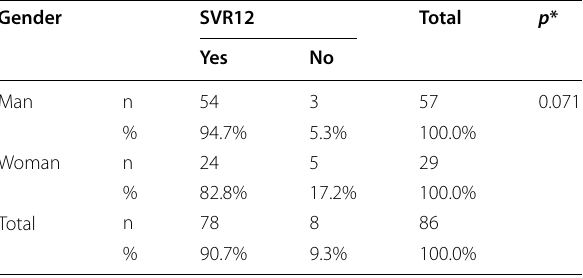
Table 4 Analysis of the correlation of gender with virological response